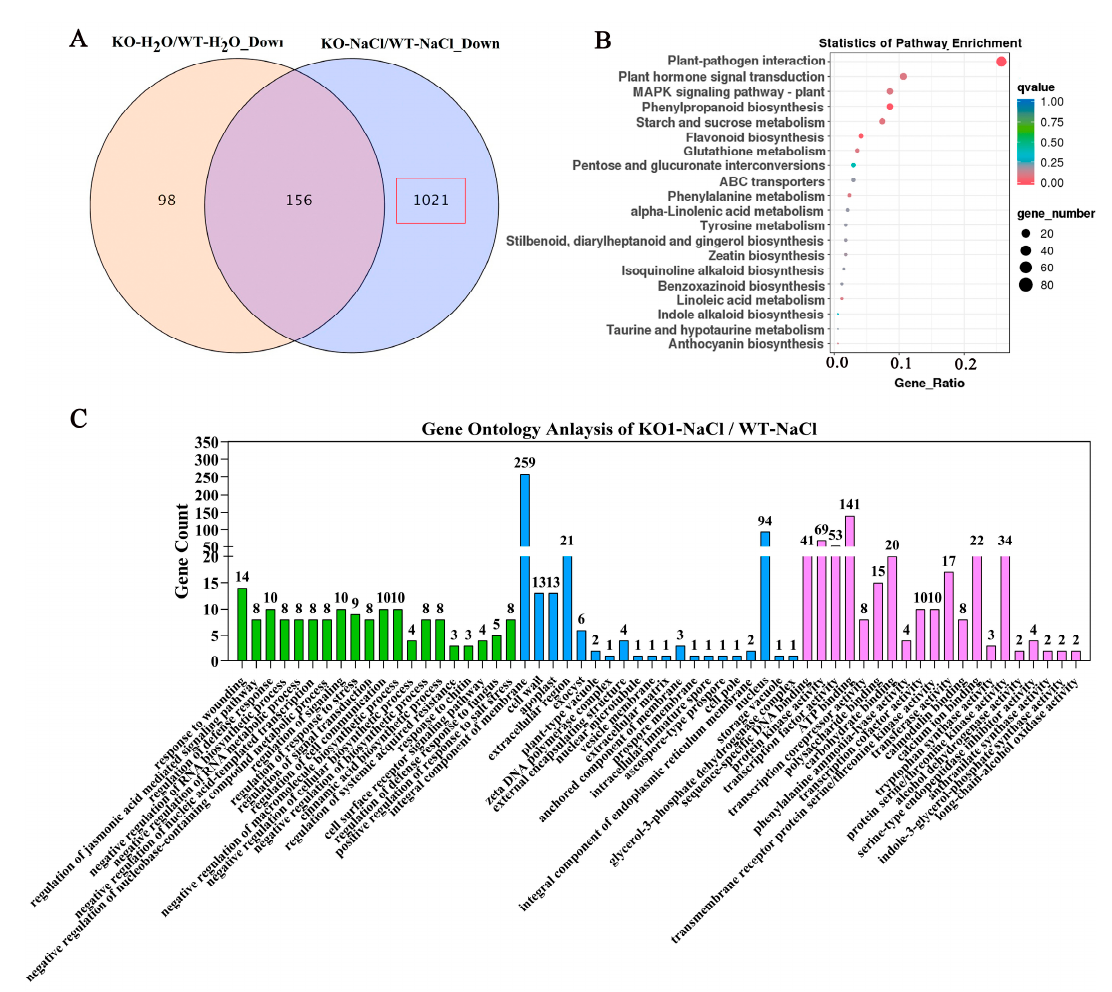
Figure 11. GO and KEGG enrichment analyses of DEGs regulated by OsJRL40 . ( A ) Venn diagram showing the number of genes up-regulated (fold change > 1.5) in KO1 plants compared with WT plants under normal and salt stress conditions. ( B ) KEGG enrichment results. ( C ) Categorization and functional annotation of DEGs detected in KO1 plants under salt stress. The different categories were as follows: biological process ( green columns ), cellular component ( blue columns ), and molecular function ( purple columns ).